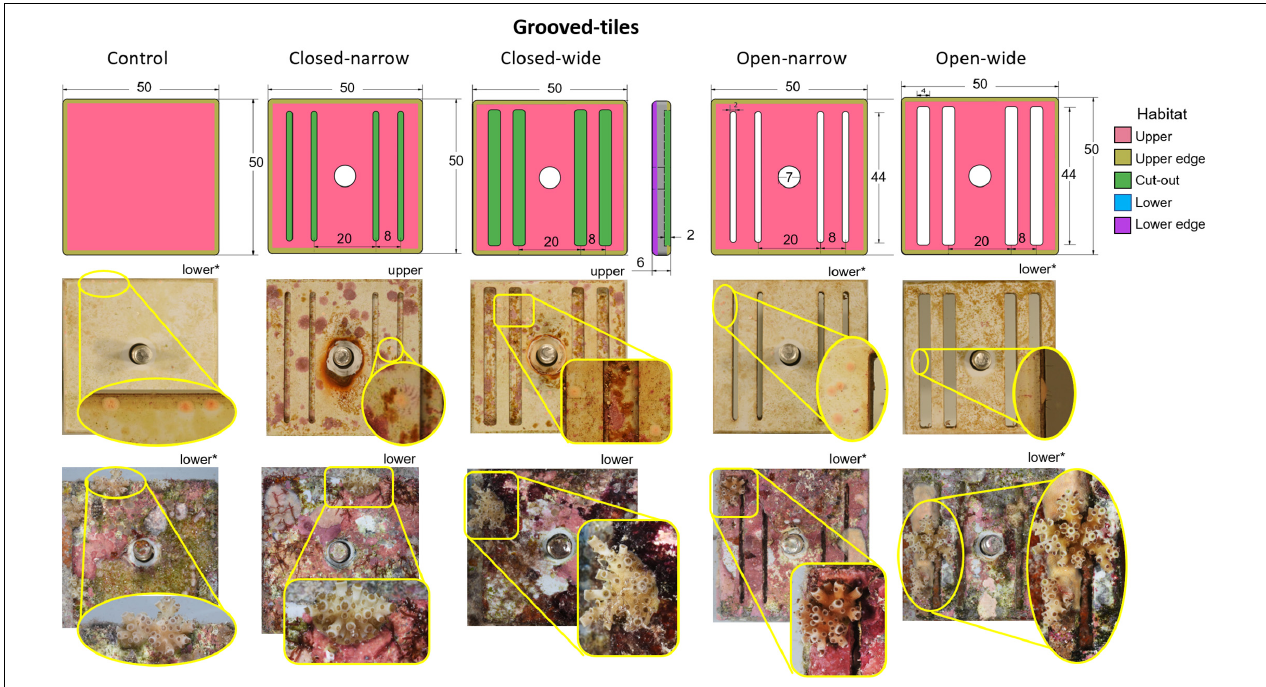
FIGURE 2 | Grooved-tiles. Schematic diagrams (top row) with corresponding representative device images immediately after settlement (middle row) and after retrieval from a 1-year field deployment (bottom row) for five grooved-tile types. Colour shading in the first row indicates settlement habitats; note that only upper and edge surfaces are shown in this row. Insets for each image in the middle and bottom rows show close-ups of the Acropora tenuis spat or juvenile colonies, respectively, on each device type. Whether each image shows the top side or under side of the device is indicated and devices identified by asterisks show the same corals as spat and juveniles. No spat on the top sides of any closed grooved-tiles survived. The brightness and contrast of inset images have been adjusted to improve the discrimination of coral spat and juveniles. In the top row, numbers indicate size in